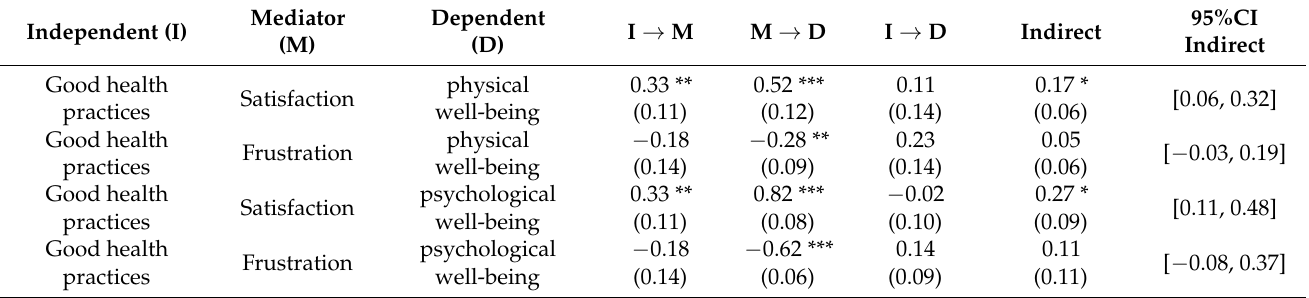
Table 5. Indirect effects of Satisfaction/Frustration of psychological needs (mediator) on the re- lationship between good health practices (independent) and physical/psychological well-being (dependent).